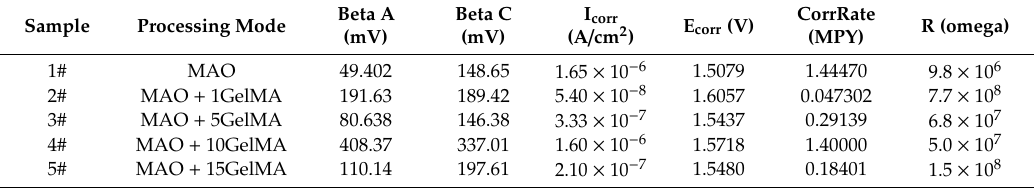
CorrRate: corrosion rate; R: polarization impedance.